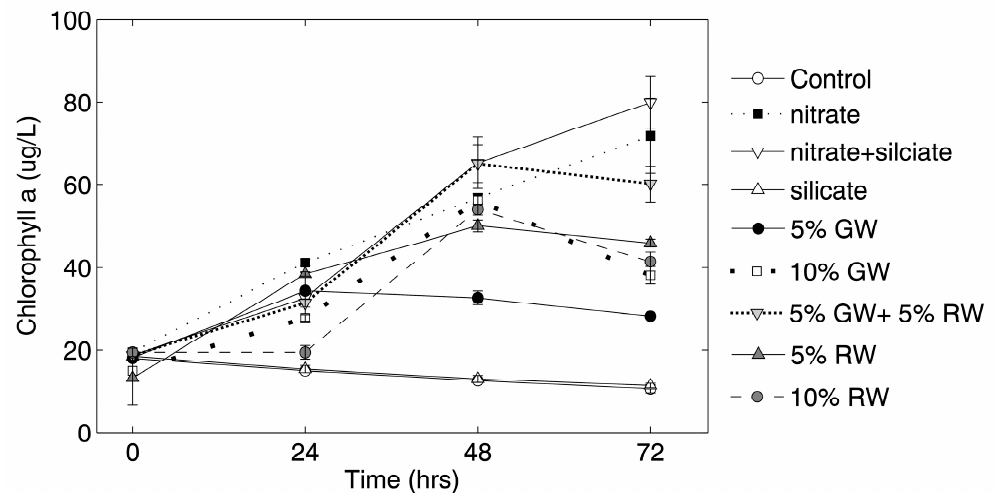
Figure 2. Chlorophyll a concentration at each time point for each treatment. All treatments except silicate and 5% groundwater were different from the control at the 48 h time point ( p < 0.05).